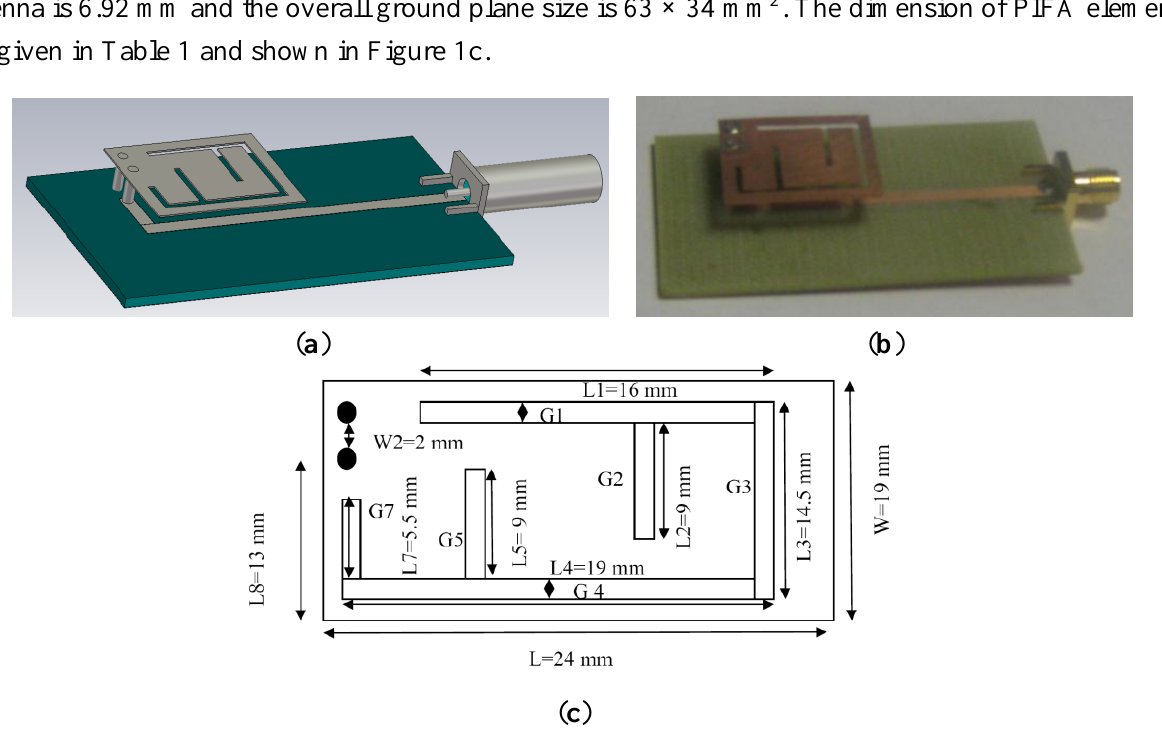
Figure 1. ( a ) Software design; ( b ) Fabricated version; (c) Schematic diagram of the dual band planar inverted F antenna PIFA. Table 1. Dimension parameters of the dual band planar inverted F antenna